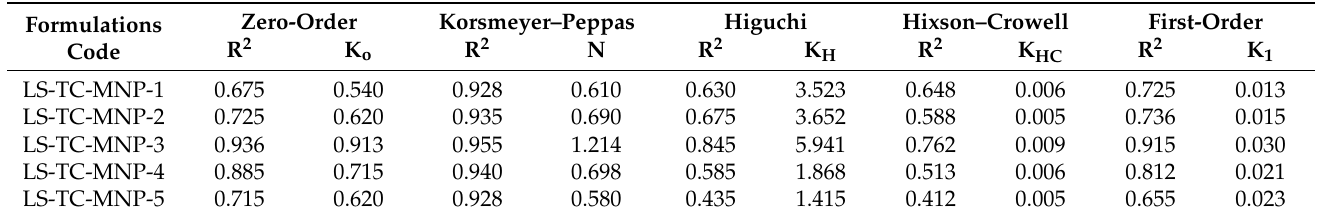
Figure 14. Graph showing the percentage drug release vs. time, from the five LS-TC-MNPs fabricated with different concentrations of thiolated chitosan (mean ± , n = 3). Table 2. Table showing in-vitro release kinetic modeling of five LS-TC-MNPs fabricated with different concentrations of thiolated